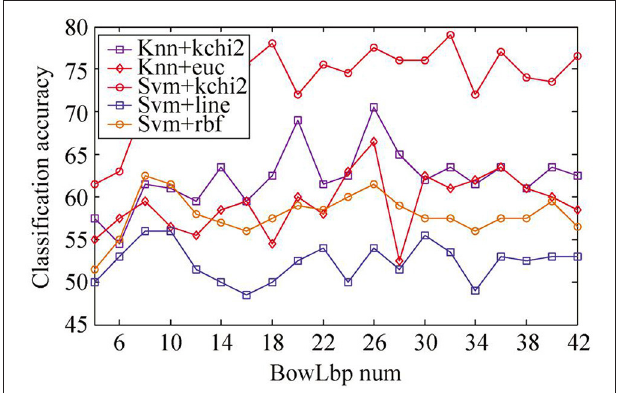
FIGURE 7 | Classification accuracy of different classifiers with BowLbp feature on sample set A.